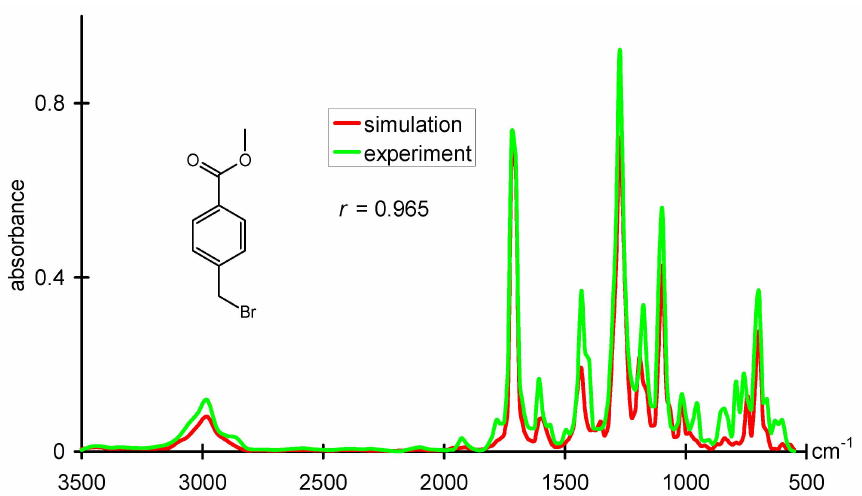
Figure 5. Comparison of an experimental infrared spectrum with an infrared spectrum obtained from modeling a dataset where structures are represented by a radial distribution